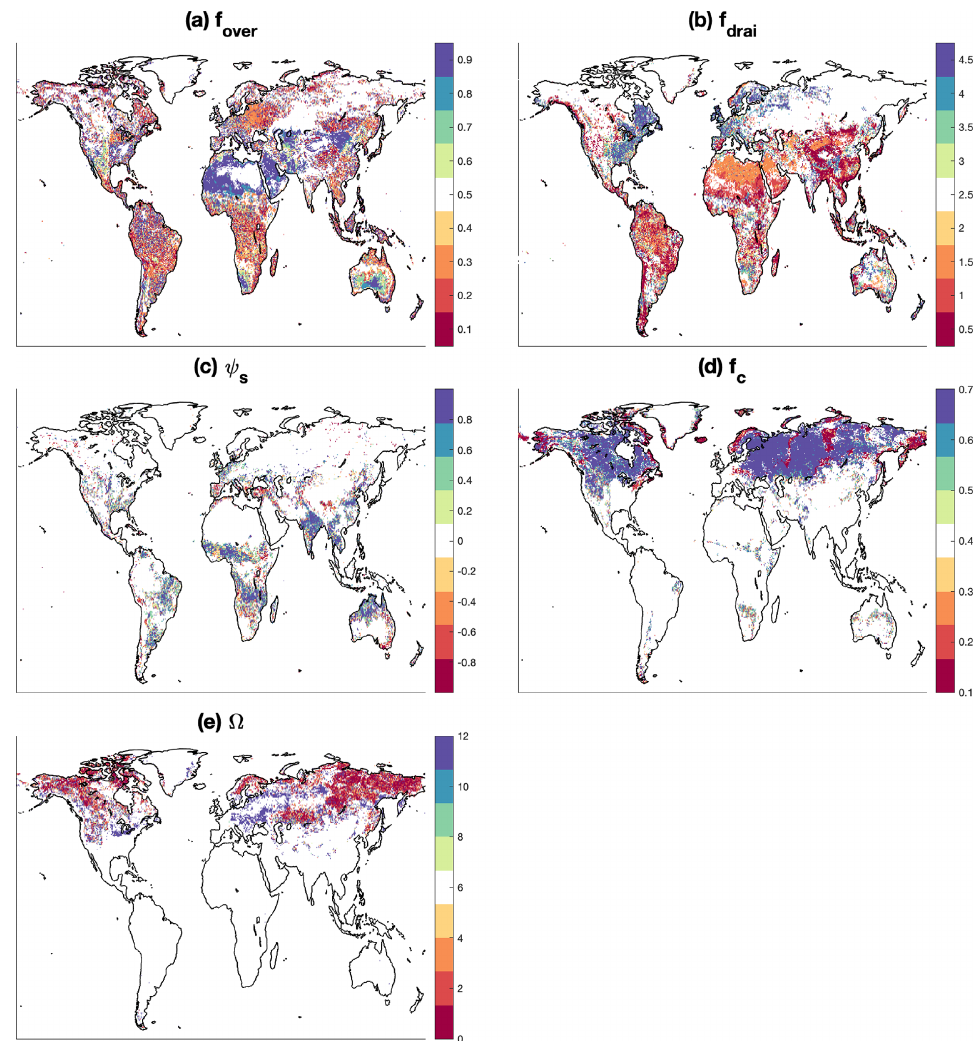
Figure 7. Optimal values for the sensitive parameters. The default values for the parameters are defined at the midpoint of the color map. There are no certainty bounds for ψ s from different grid cells because it is determined by the soil properties. Therefore, the values of ψ s are scaled to [ − 1, 1] in panel (c) for each grid cell with the corresponding upper bound ( ψ s , max ) and lower bound ( ψ s , min ) : 2 ψ s , max + ψ s , min ψ s , max − ψ s , min